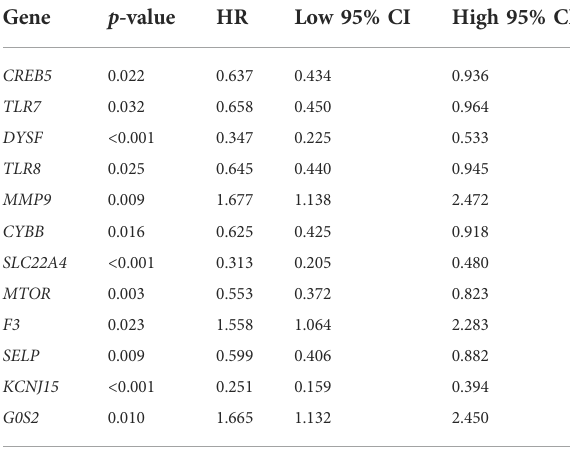
TABLE 3 NET-related genes with signi fi cant prognosis in disease- speci fi c survival analysis. Gene p